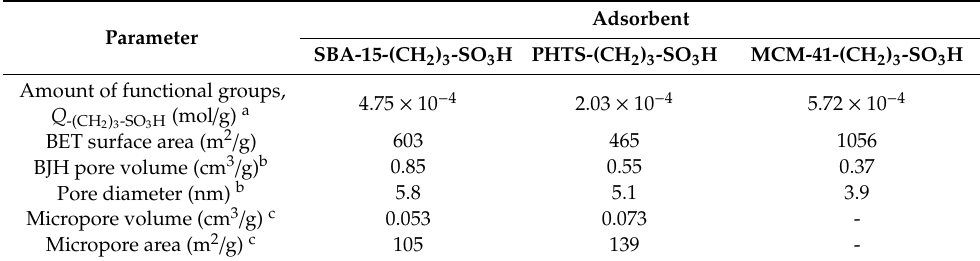
Table 2. Textural properties of propyl-sulfonic acid-modified mesoporous